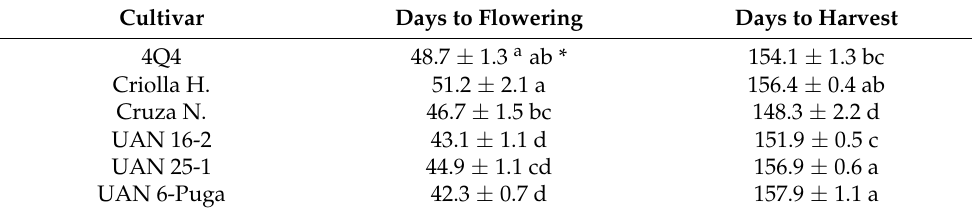
Table 4. Development of different cultivars of roselle produced in greenhouse hydroponics. Cultivar Days to Flowering Days to Harvest 4Q4